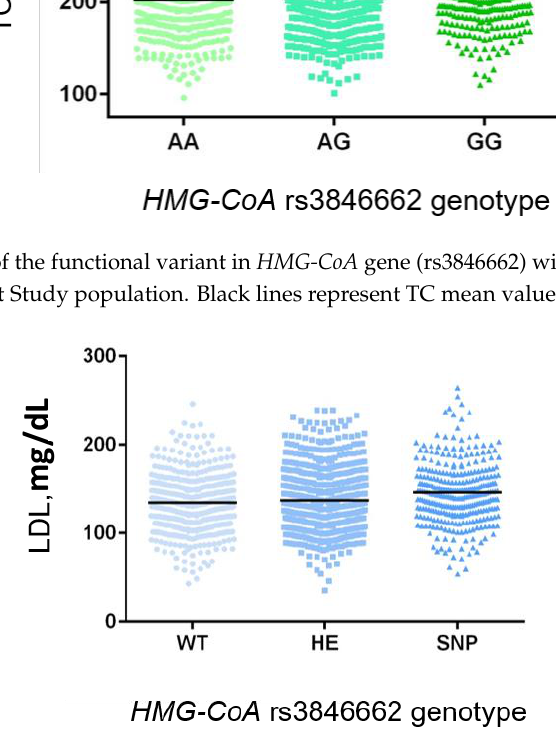
Figure 2. Association of the functional variant in HMG-CoA gene (rs3846662) with LDL-C level in a subset of the Brisighella Heart Study population. Black lines represent LDL-C mean value.